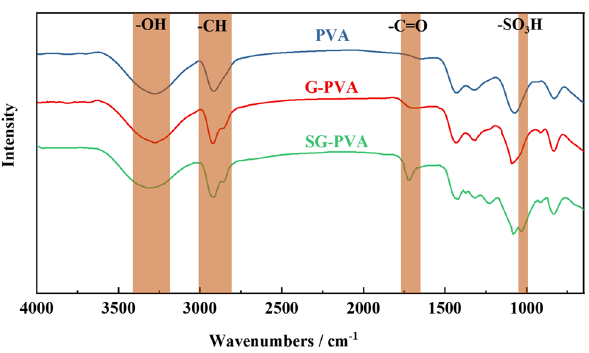
Figure 2: FT - IR spectra of PVA, G - PVA, and SG - PVA.